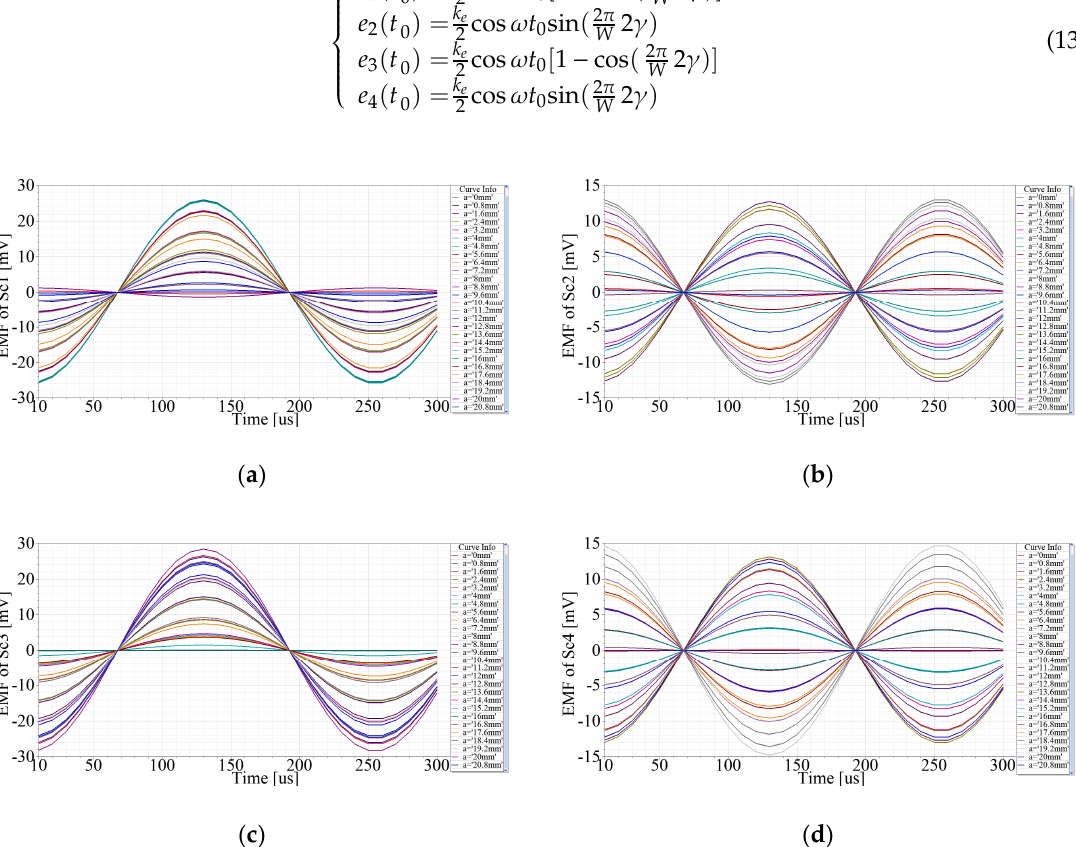
Figure 5. Finite Element Analysis (FEA) simulation results, EMFs of Sc1~Sc4 when primary coil moves 20.8 mm with a step of 0.8 mm. (a) EMF of Sc1. (b) EMF of Sc2. (c) EMF of Sc3. (d) EMF of Sc4.